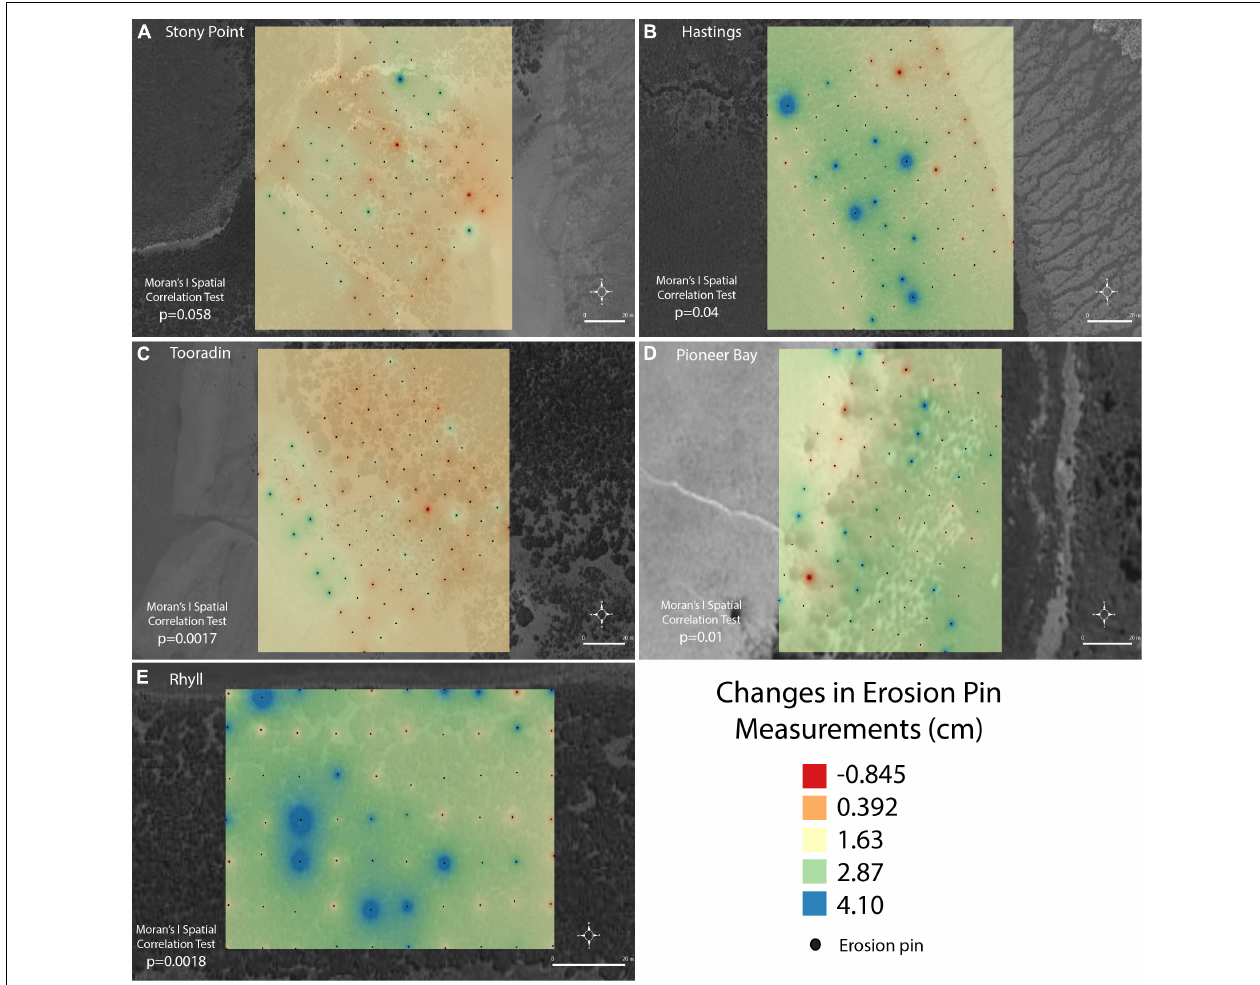
FIGURE 6 | Long term changes recorded at each erosion pin during experiment across the sites (A) Stony Point, (B) Hastings, (C) , Tooradin, (D) Pioneer Bay, (E)